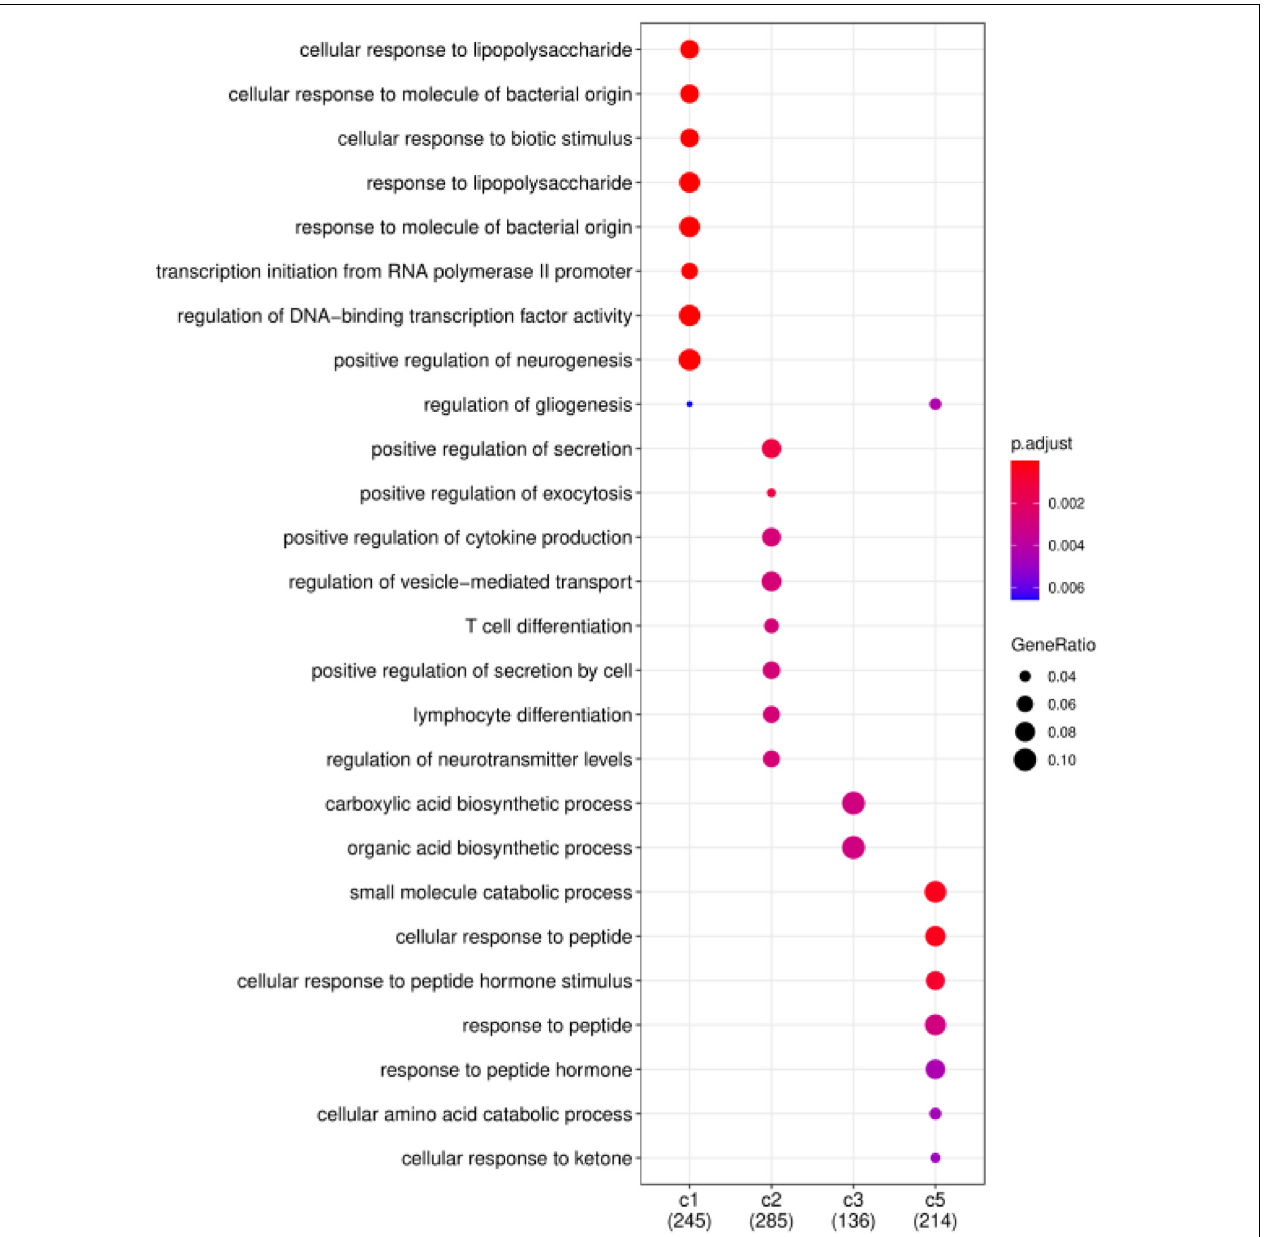
FIGURE 7 | Functional enrichment analysis on BRCA. Significantly different GO biological processes derived from driver genes of different cancer